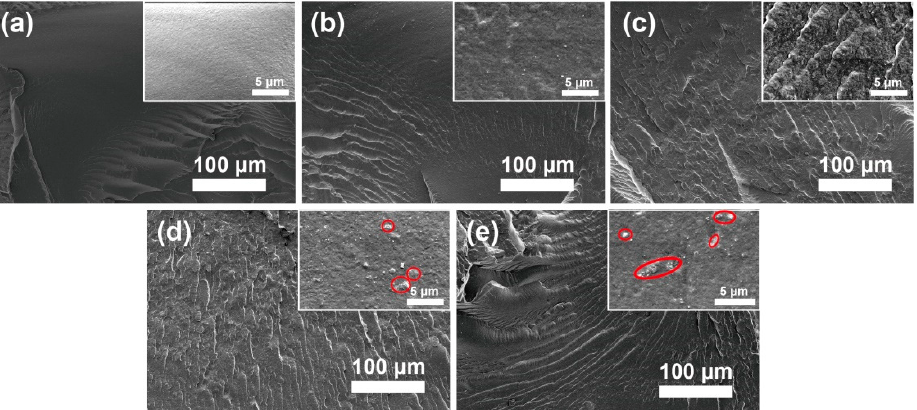
Figure 3. Fracture surface SEM images of poly(butylene adipate-co-terephthalate) (PBAT) nanocomposites. ( a ) MgO@CTAB-0, ( b ) MgO@CTAB-1, ( c ) MgO@CTAB-3, ( d ) MgO@CTAB-5, and ( e ) MgO@CTAB-7.